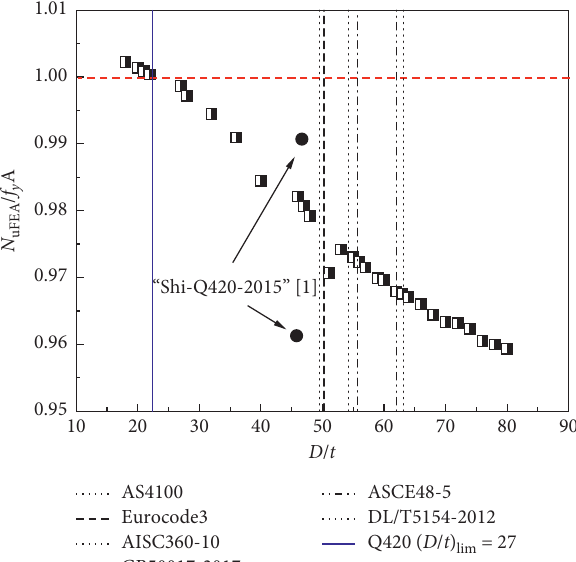
Figure 13: D / t limit for local